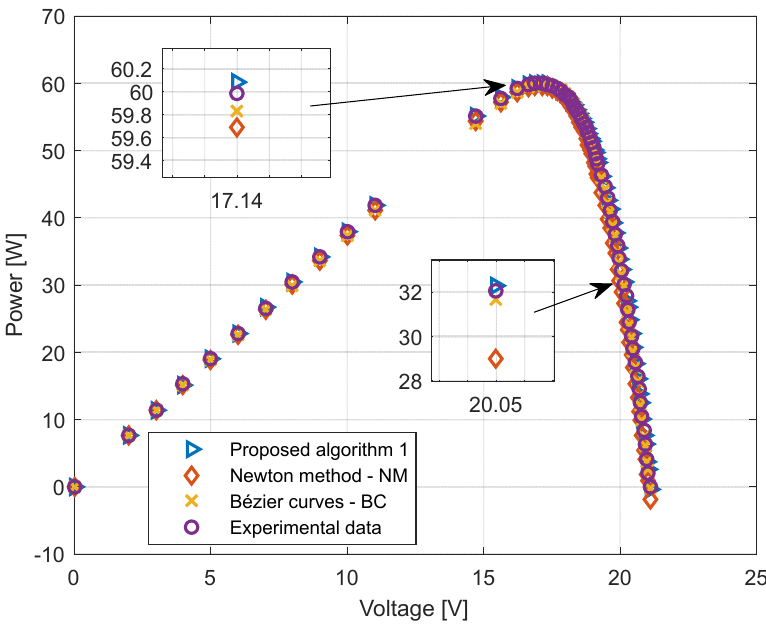
Figure 8. Power-voltage characteristics of the Solarex MSX–60 PV solar module.